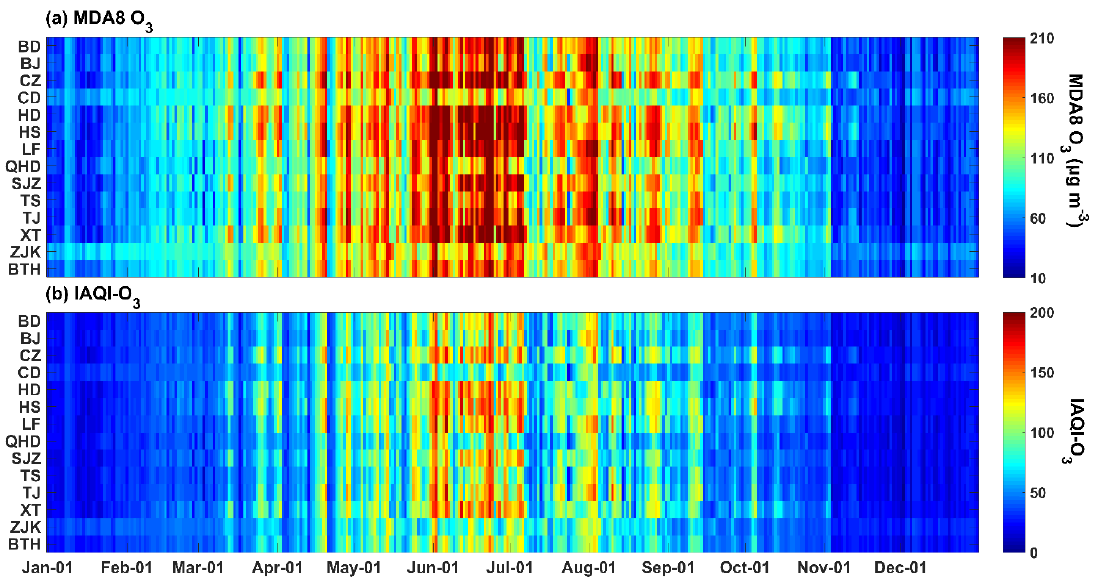
Figure 6. Daily MDA8 O 3 concentration ( a ) and IAQI of the daily average O 3 concentration ( b ) in 13 cities and the whole BTH region.